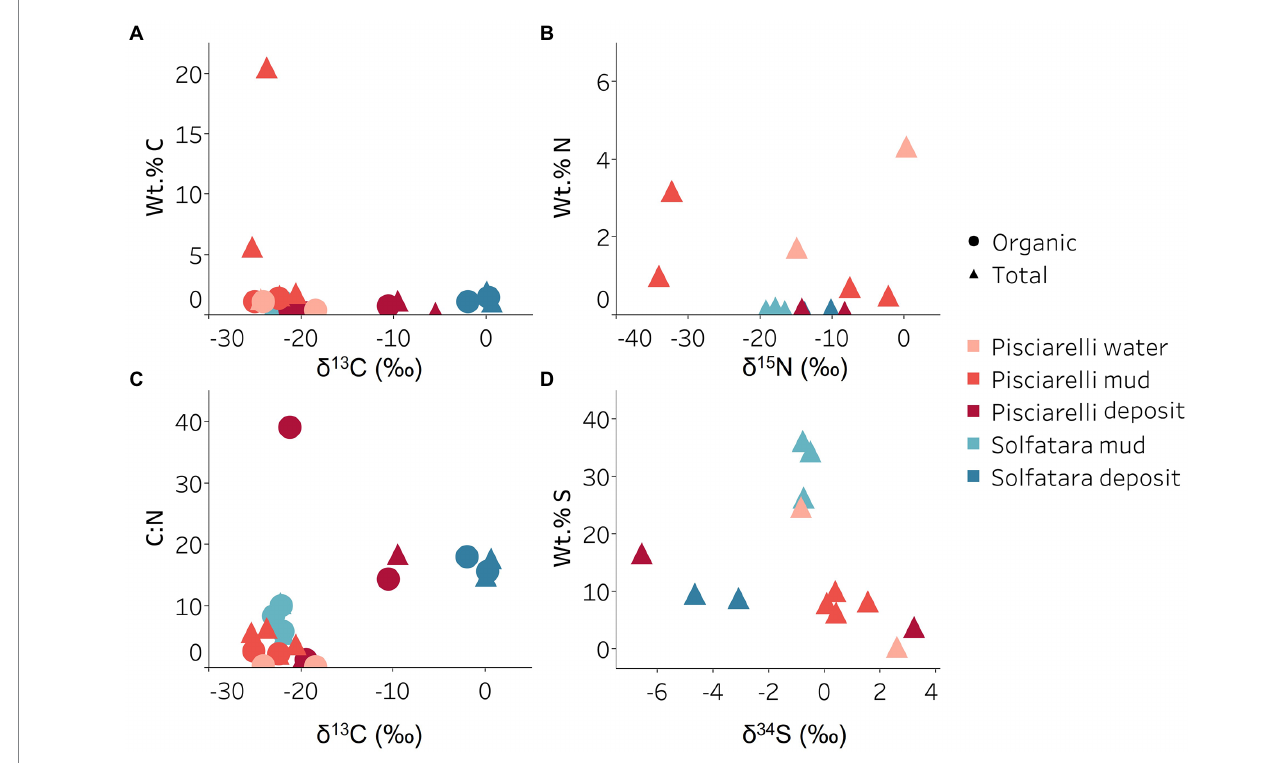
FIGURE 9 Carbon, nitrogen, and sulfur isotope values measured in Solfatara and Pisciarelli hydrothermal systems. (A) Total Carbon (TC) wt.%, Total Organic Carbon (TOC) wt.% and δ 13 C values. The wt.% values of TC and TOC are very similar indicating that carbon measured in the samples is mostly organic. The δ 13 C values exhibit a wide range of values. (B) Total Nitrogen wt.% and δ 15 N values. Pisciarelli mud and water have the highest concentrations of N. The δ 15 N values exhibit a large variation with values ranging from 0.41 to − 34.04‰. (C) C:N ratio and δ 13 C values both point out that most of the carbon measured shows values typical for microorganisms with various carbon fixation pathways. (D) Total Sulfur wt.% and δ 34 S exhibit values characteristic for oxidized fumarolic H 2 S and sulfur with sedimentary